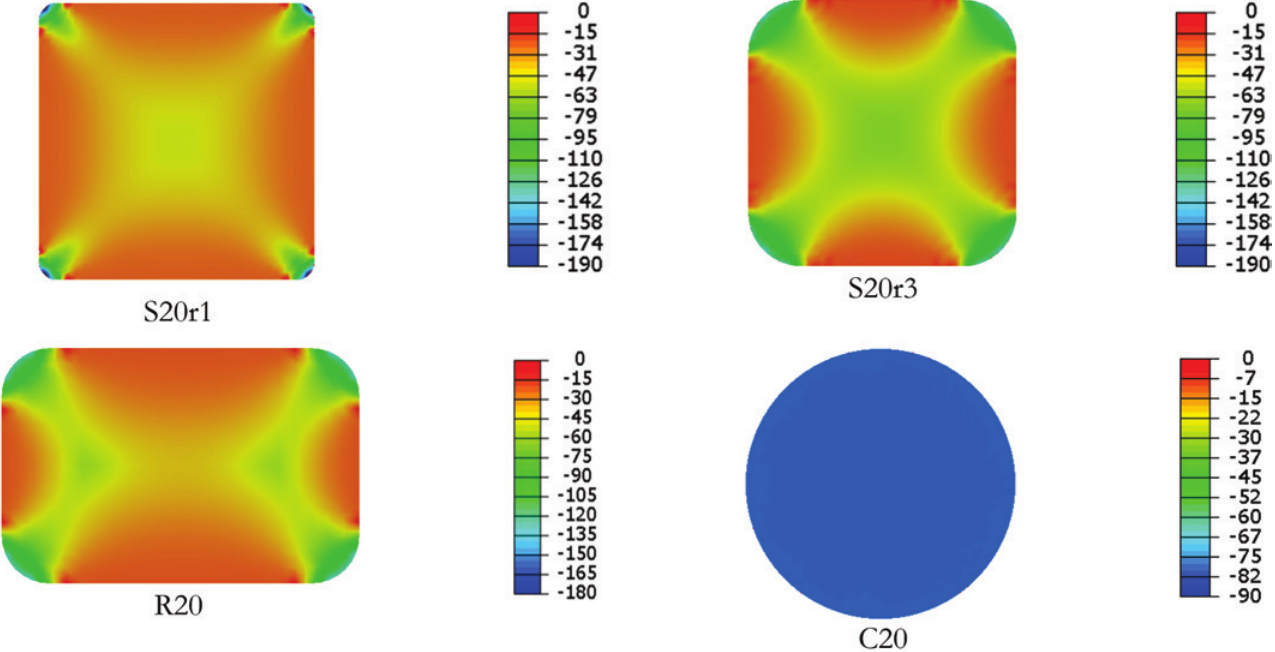
Figura 10 Distribuição das tensões axiais compressão na seção transversal de em pilares confinados com PRF obtidas na modelagem numérica (valores em MPa)